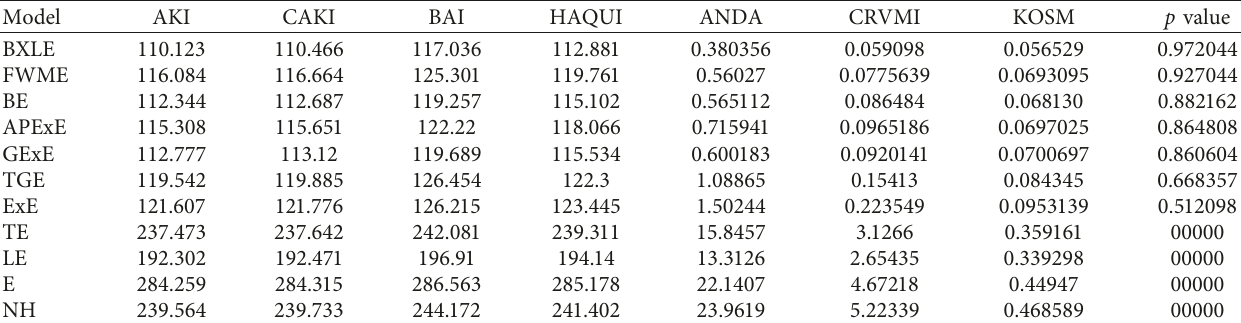
Table 11: Discrimination measures of the BXLE model and other competing models for first dataset.